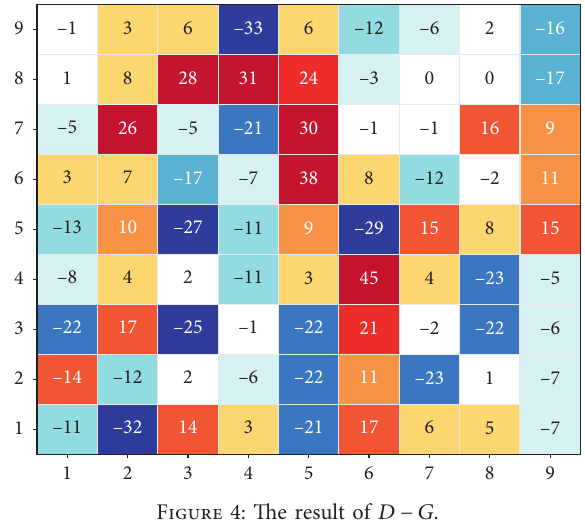
Figure 4: The result of D − G .